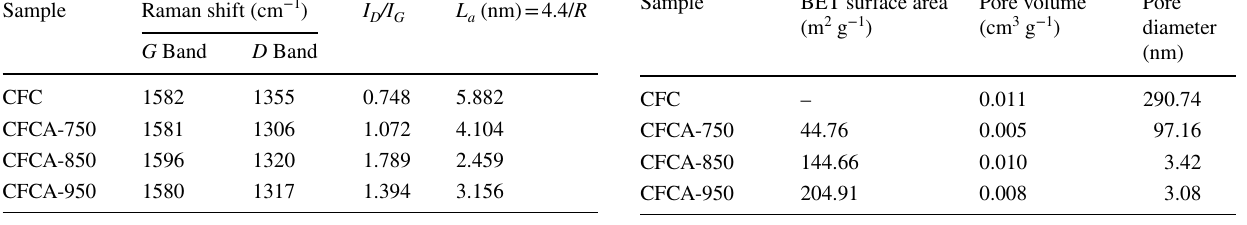
Table 3 BET surface area and pore parameters of CFC and CFCAs